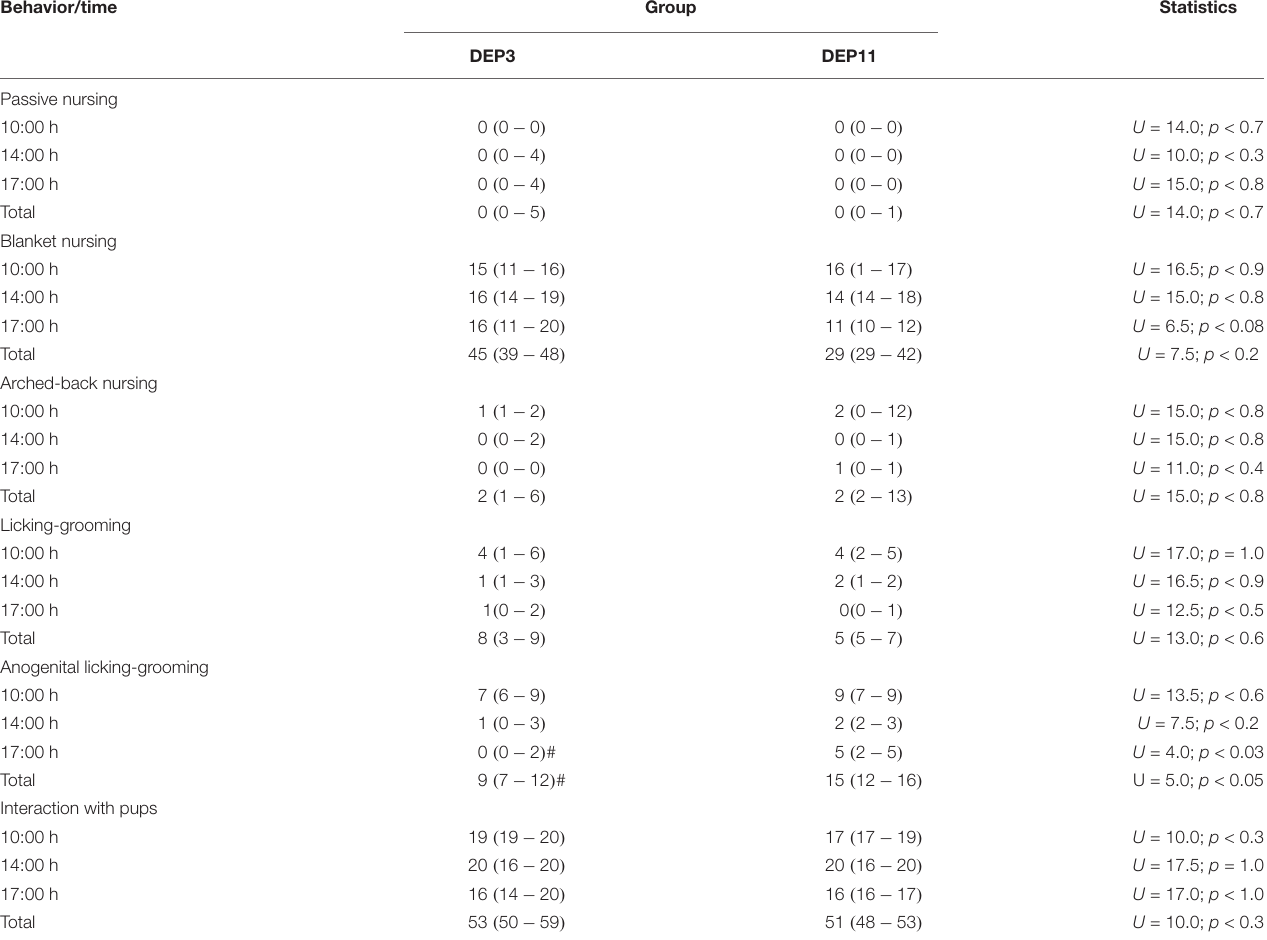
TABLE 3 | Frequency (median – 25 and 75 percentile) of the main components of maternal care on the day of reunion of the litters with their mothers. Behavior/time Group Statistics DEP3 DEP11